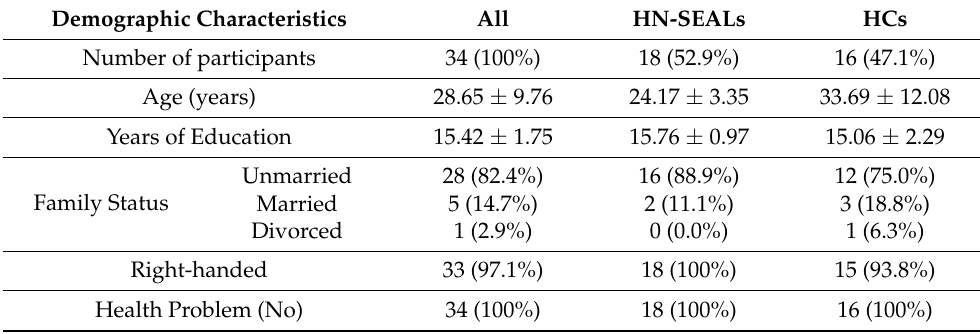
Table 1. Demographic characteristics of participating subjects per